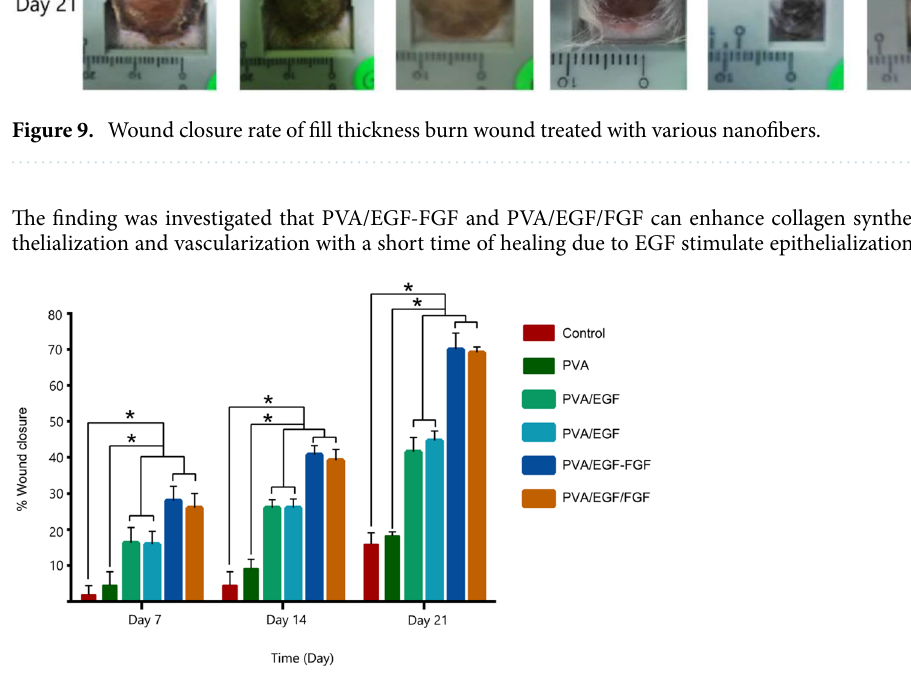
Figure 10. The percentage of wound closure treated with different